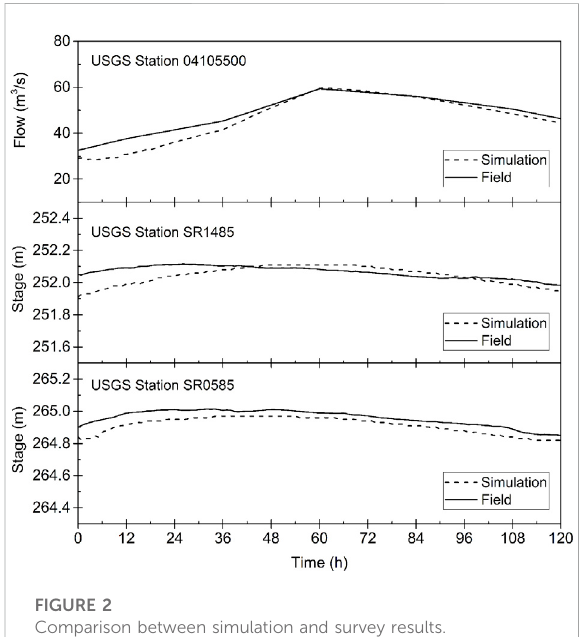
Comparison between simulation and survey